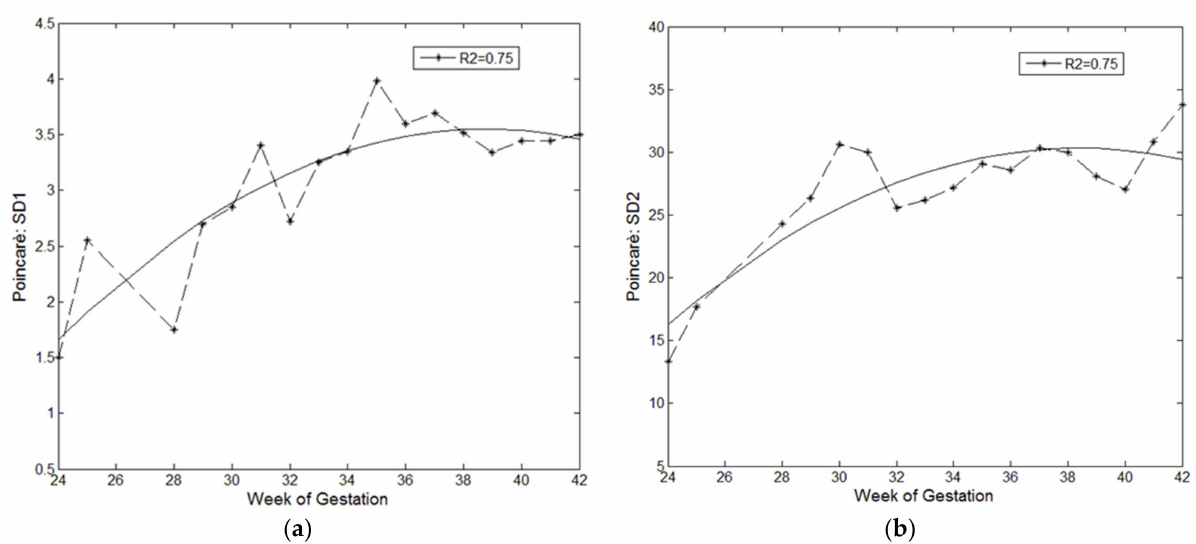
Figure 4. Trends of Poincar é indices according to the pregnancy period: ( a ) regression graphs of Poincar é SD1 parameter as a function of the gestational week; ( b ) regression graphs of Poincar é SD2 parameter as a function of the gestational week. For each graph, trend lines (dashed), fitting lines (solid), and R-squared values (R2) are